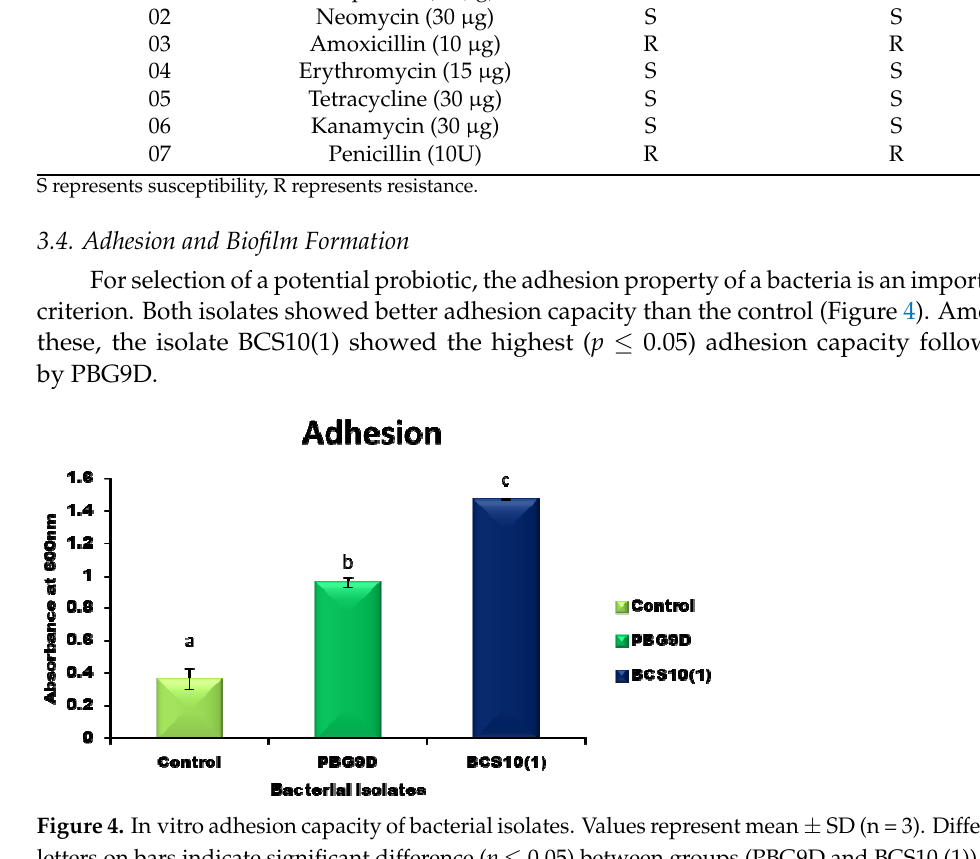
Table 4. Biochemical characterization of bacterial strains isolated from fish